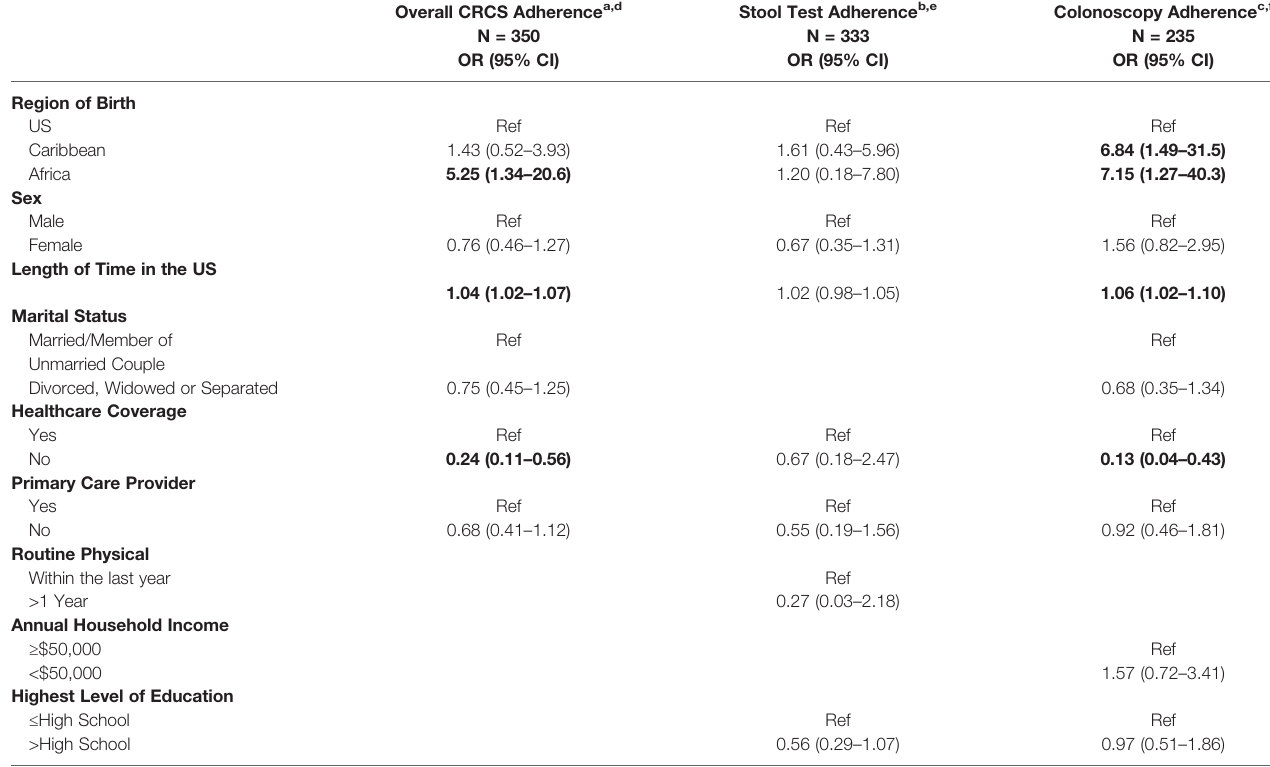
TABLE 3 | Adjusted logistic regression for the association between region of birth and colorectal cancer screening adherence (N =